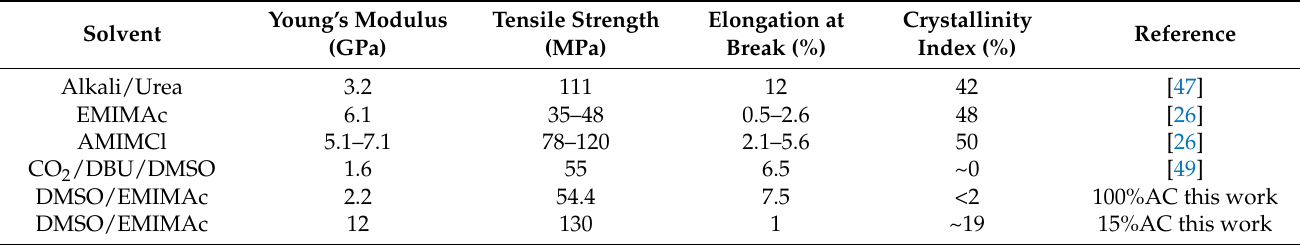
Table 1. Mechanical properties (Young’s modulus, tensile strength, and max elongation at break) and crystallinities of cellulose regenerated from various solvent